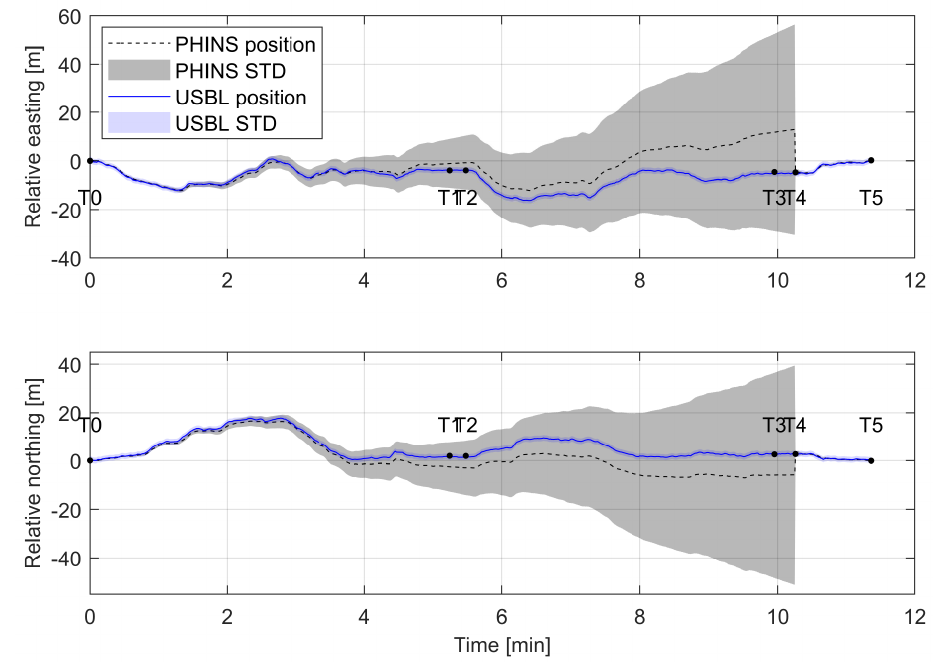
Figure 14. Relative ROV position throughout the experiment. Blue continuous line presents the ROV ground truth USBL position. The PHINS estimated position, while operating in pure inertial mode, is shown with black dashed line. At time T4, PHINS was switched to operate in INS + USBL mode, and the ROV was docked at